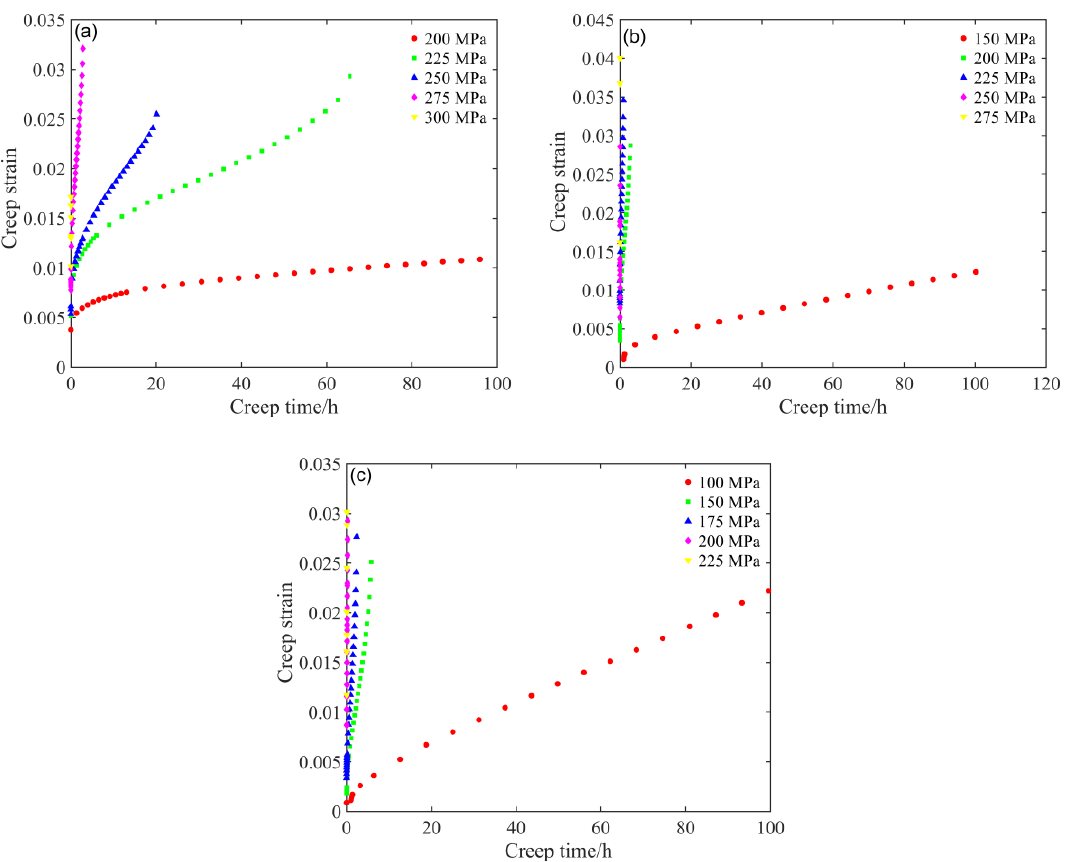
Figure 5. Creep curves of CGI under different test stresses: ( a ) 450 °C, ( b ) 500 °C, and ( c ) 550 °C.